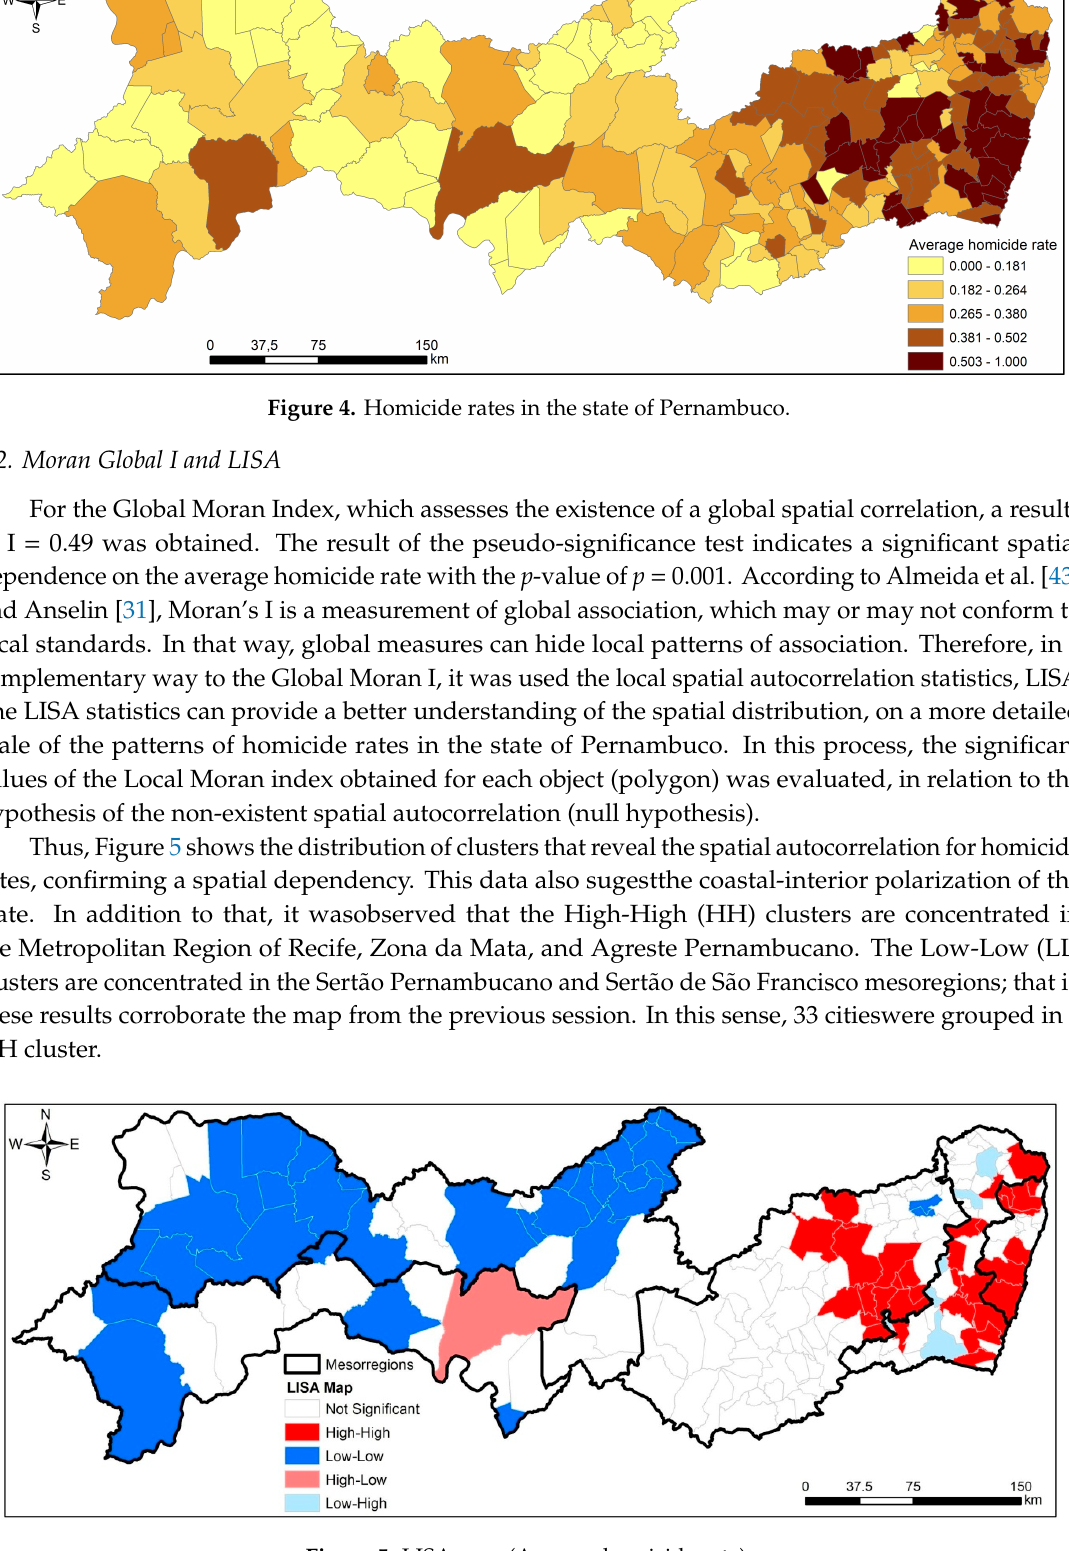
Figure 5. LISA map (Average homicide rate).